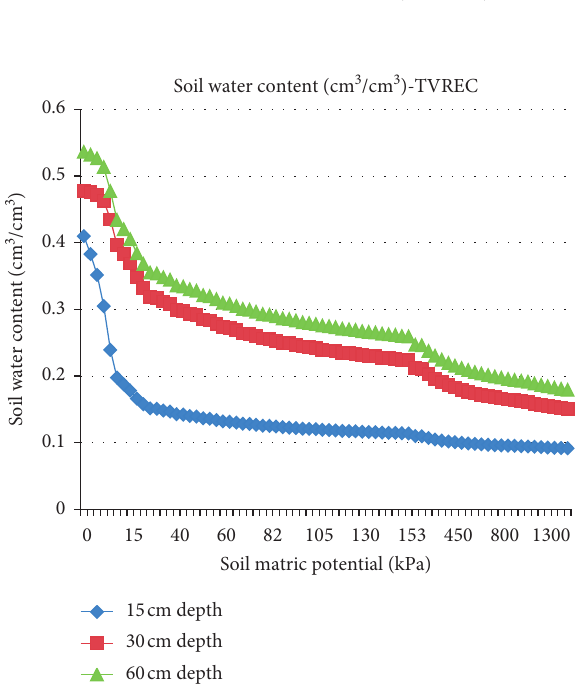
Figure 1: Soil water retention curves created using the van Genuchten equation for each depth (15, 30, and 60cm) to convert the soil water content data into soil matric potential in 2014 and 2015 at